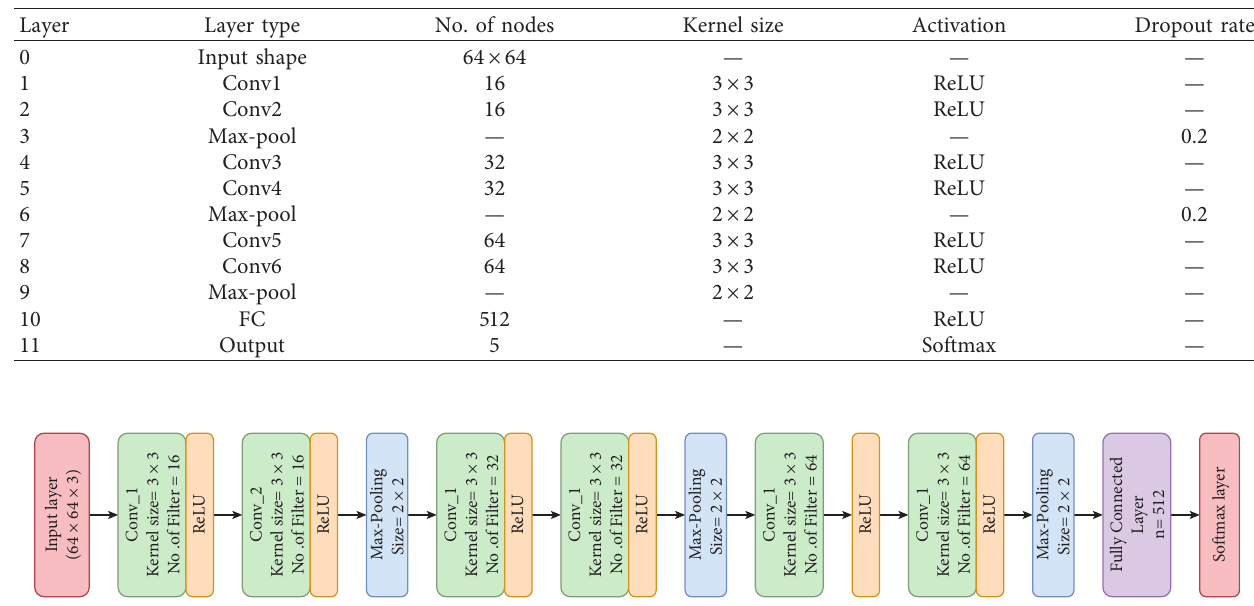
Table 3: Structure of custom CNN model.